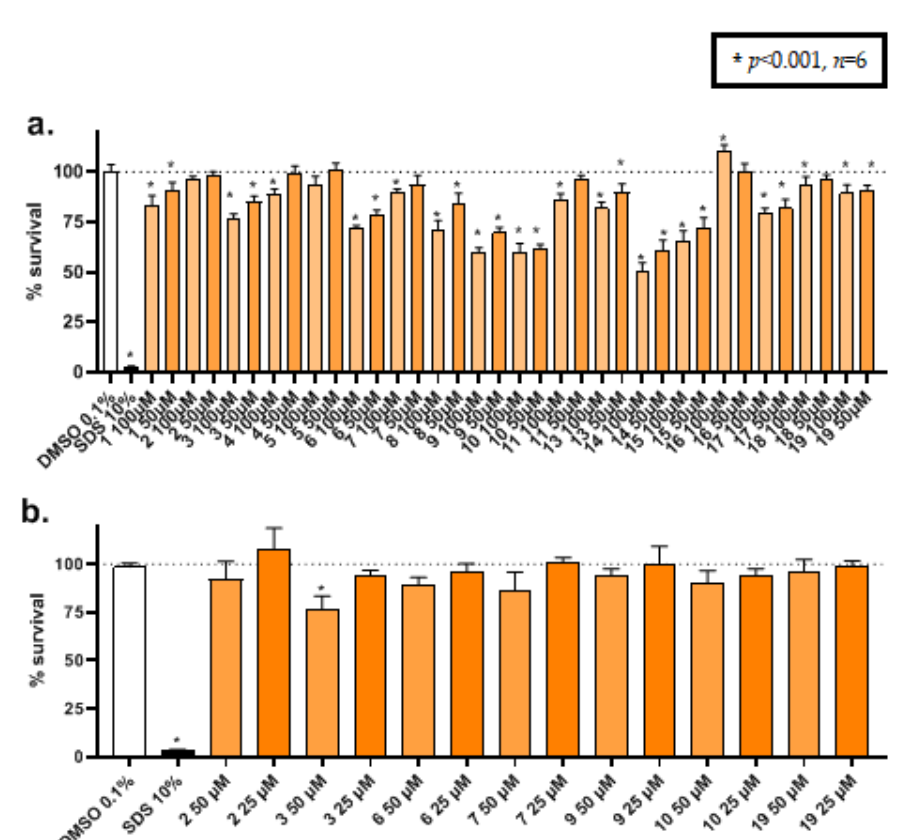
Figure 6. Cytotoxic screening of all compounds in MCF7/S0.5 cells ( a ) and toxicity of selected active compounds in non-cancerous cell line HK-2 ( b ) at two different lower concentrations. Results are shown as the mean ± SD. of three independent experiments. As vehicle was used DMSO 0.1% and sodium dodecyl sulfate 10% (SDS 10%) as negative control. Concentrations of 100 µ M correspond to weight concentrations of 46 to 54 µ g/mL, depending on the molecular weight. Concentrations of 50 µ M correspond to 23 to 27 µ g/mL and 25 µ M to 11–14 µ g/mL. Statistical analysis was performed with one-way ANOVA in order to compare the results to the vehicle (100% viability).